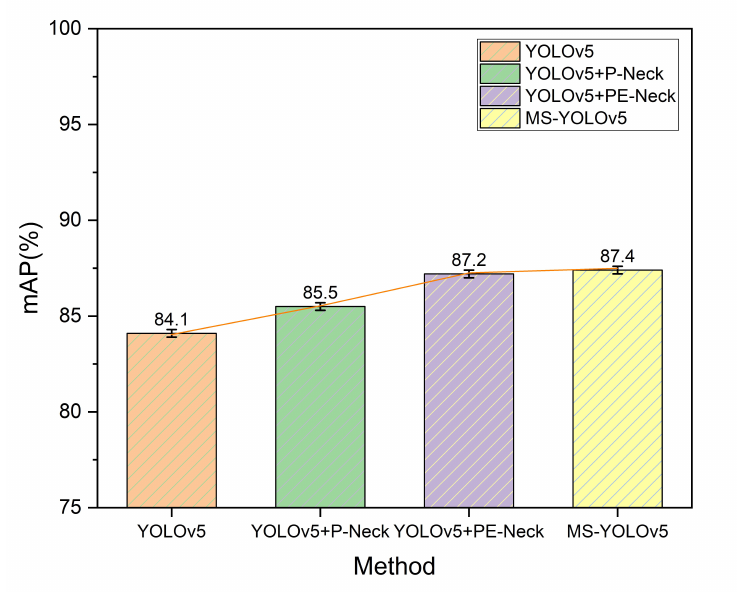
Figure 9. YOLOv5 improved to MS-YOLOv5 mAP comparison chart for each